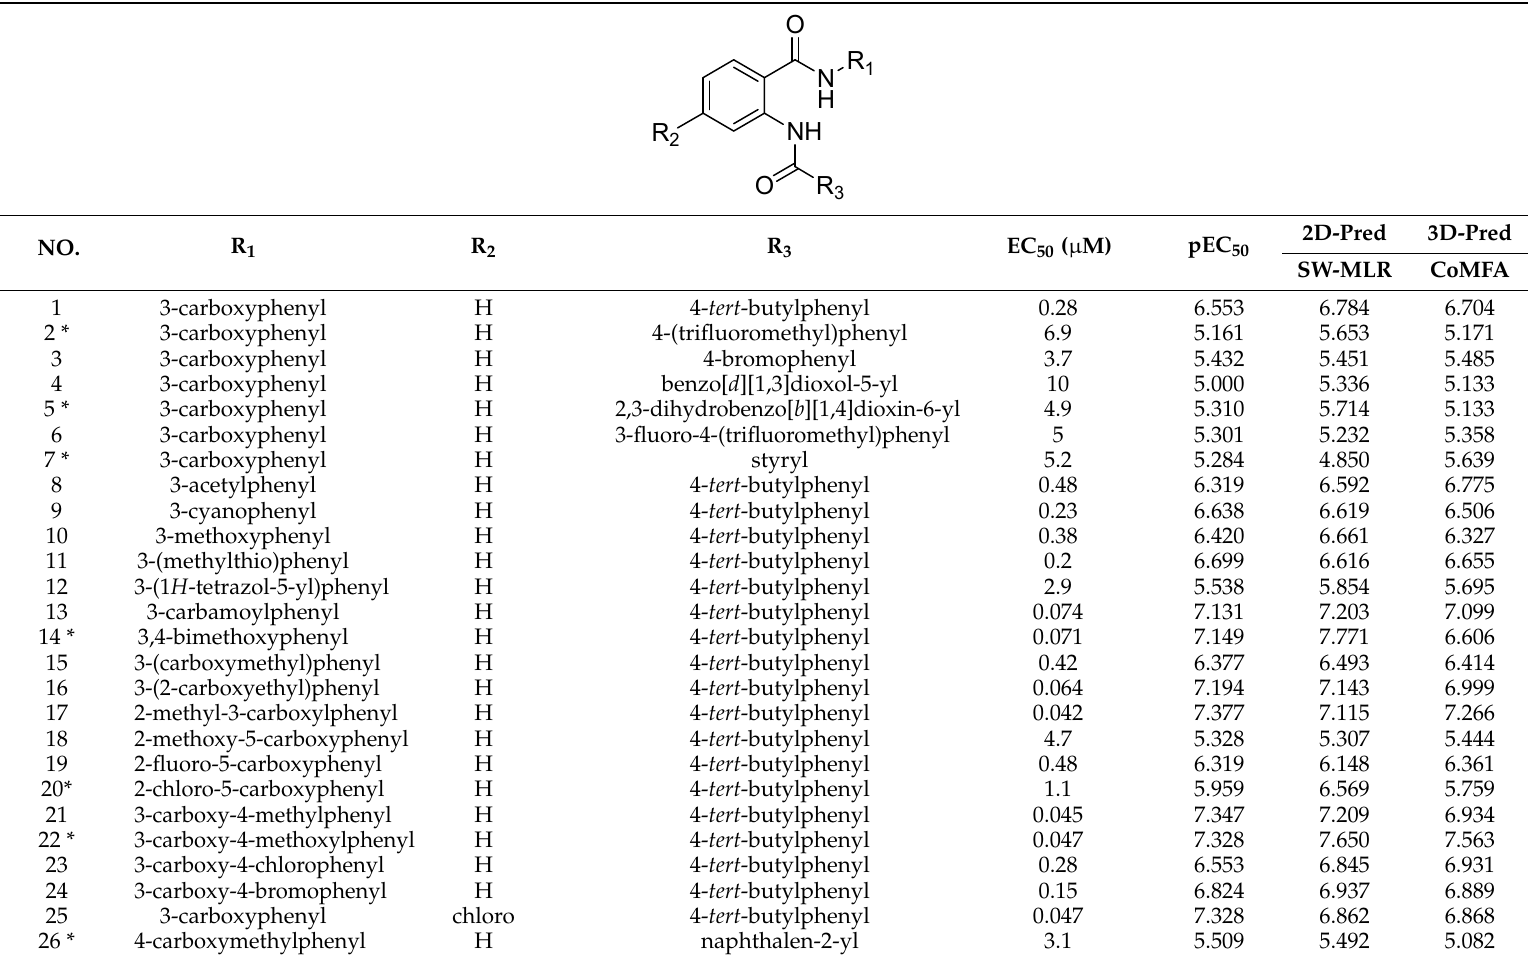
Table 3. Molecular structures and corresponding experimental and predicted pEC 50 values of the AAD as partial FXR agonists.